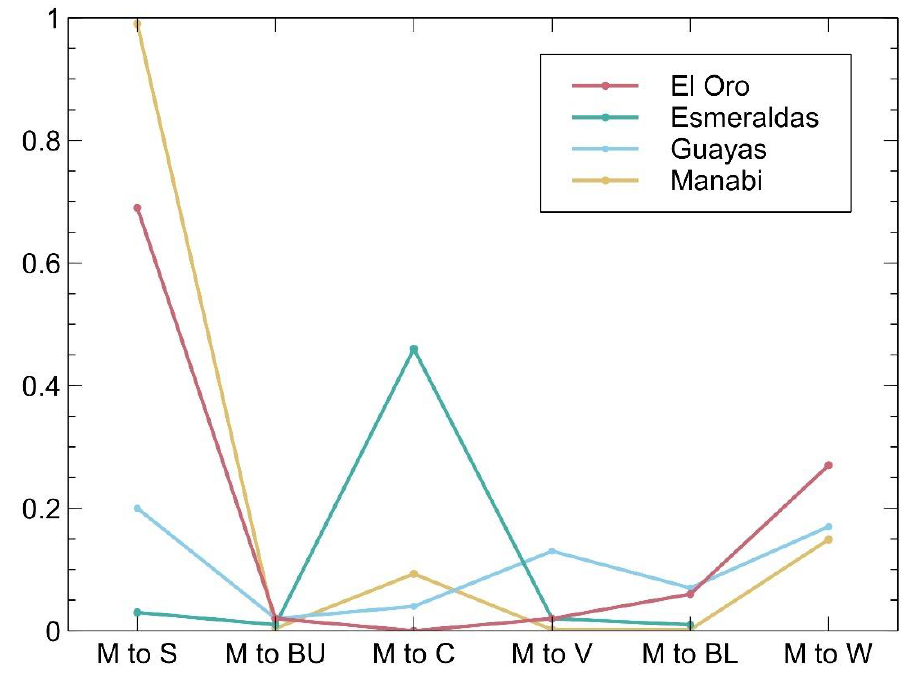
Figure 11. Intensity of annual change from mangrove to other cover categories (period 2010 – 2018), represented according to the following equation: Rtin = transition area from i to n during time period n/duration of the period area of category i to time 𝑛 × 100.